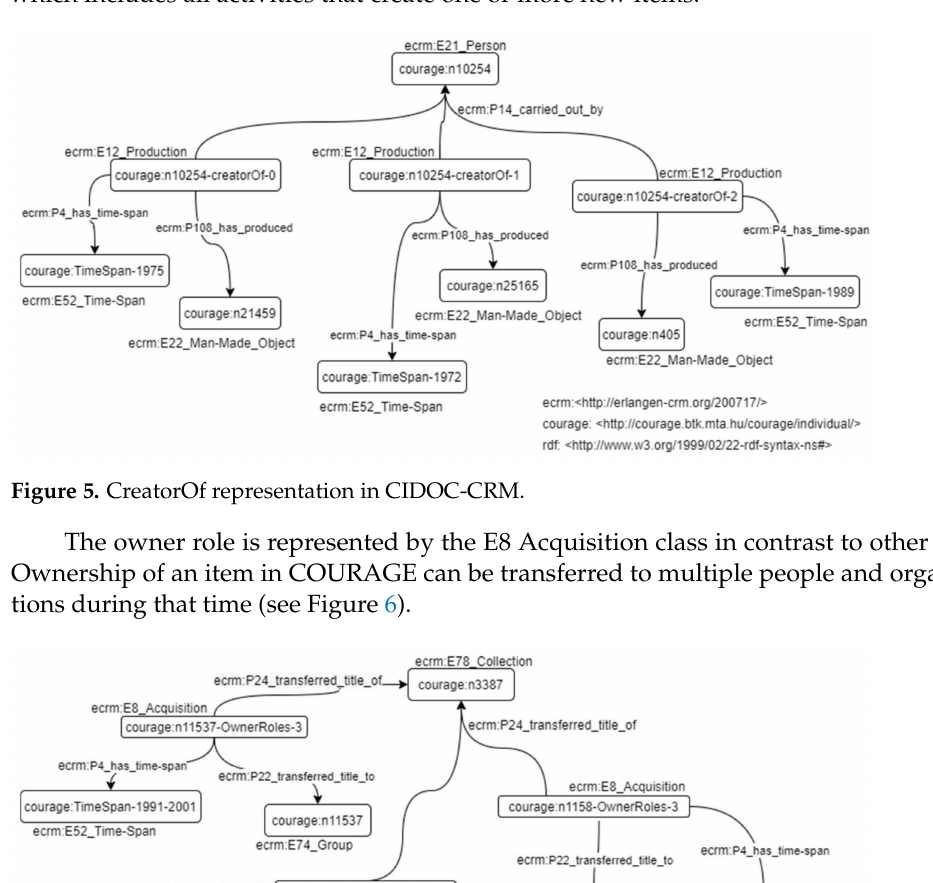
Figure 4. An example of a person first name representation in CIDOC-CRM. CreatorOf is a property in COURAGE that connects people and organizations with their own featured items. It is represented through the E12 production class (see Figure 5), which includes all activities that create one or more new items.